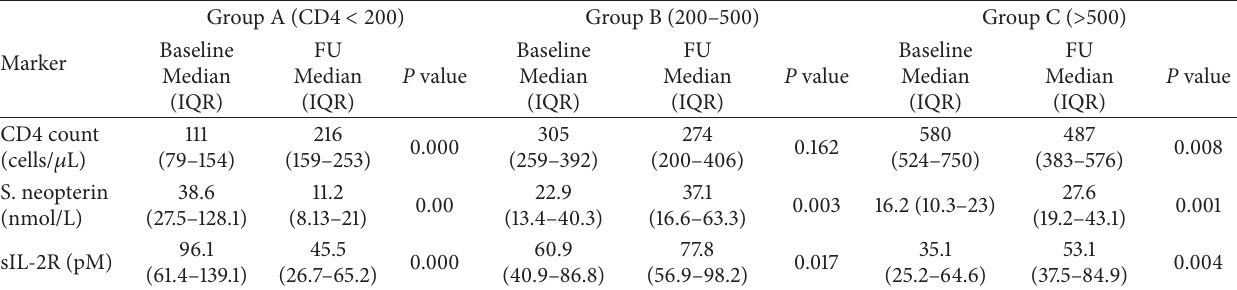
Table 2: Change in the level of markers from baseline to followup in the three